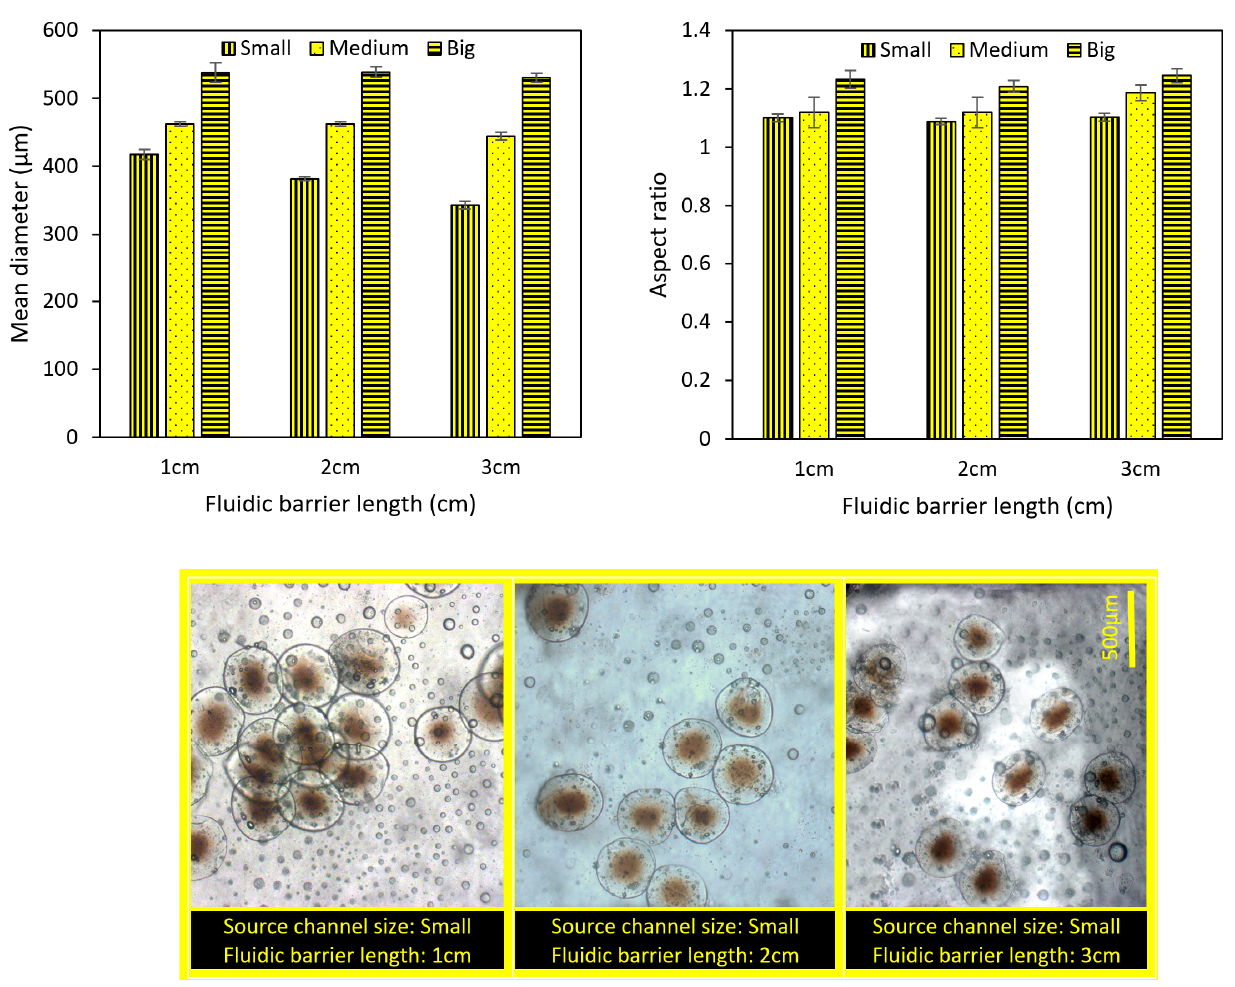
Figure 7. The size and aspect ratio (mean ± standard error) of microparticles with different fluidic barrier lengths and source channel widths (f = 50 Hz). Scale bar is 500 µm.